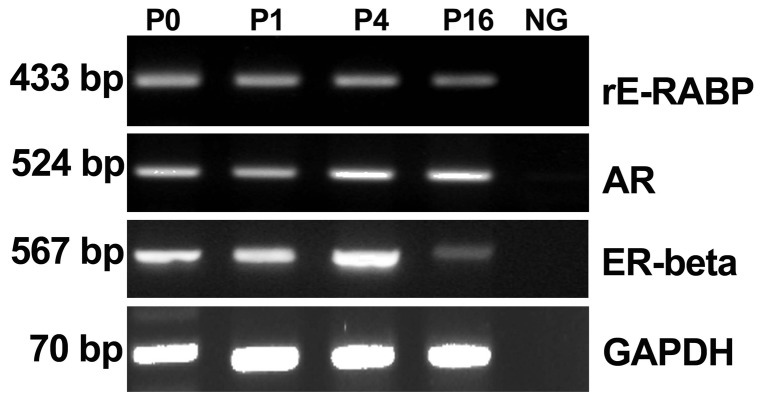
RT-PCR analysis of rE-RABP, AR, and ER-beta mRNA levels in isolated epididymal cells (P0), and cells at first, 4th, 16th passage culture in presence of trehalose.Cells were cultured in IMDM supplemented with 120(approximately at 6th day of subculture), and then harvested for RNA isolation. mRNA levels of rE-RABP, AR and ER-beta were determined by RT-PCR and mRNA of GAPDH was used as an inner control. P0, P1, P4, P16 represented the isolated epidiymal cells, the cells at the first passage, the 4th passage, and the 16th passage culture, respectively.